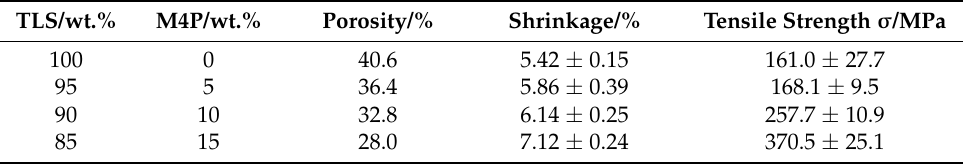
Table 2. Porosity, linear shrinkage (n = 3) and tensile strength (n = 3) of the preforms sintered from 0 to 15 wt.% fine M4P powder added to coarse TLS powder. TLS/wt.% M4P/wt.% Porosity/%